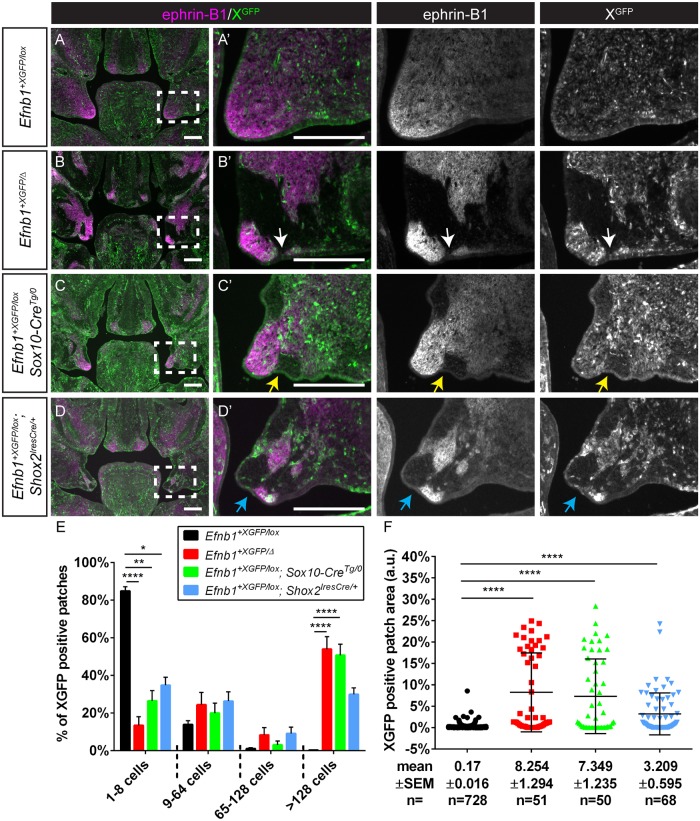
Craniofacial mesenchyme cell segregation correlates with local dysmorphology in the secondary palate.(A, A’) Immunostaining E13.5 frontal sections for EPHRIN-B1 (magenta) and GFP (green) reveals that EPHRIN-B1 protein is strongly expressed in the anterior-middle palatal shelves. Evenly distributed and intermixed XGFP expressing cells are apparent in control Efnb1+XGFP/lox embryos. (B, B’) Cell segregation is visible in the palatal shelves of Efnb1+XGFP/Δ embryos as large patches of EPHRIN-B1 and GFP expression in these structures. The palatal shelves are also smaller and dysmorphic, with changes in shape occurring at boundaries between EPHRIN-B1 expressing and non-expressing domains (white arrow). (C, C’) Generation of EPHRIN-B1 mosaicism specifically in neural crest cells using Sox10-Cre results in dramatic cell segregation in Efnb1+XGFP/lox; Sox10-CreTg/0 palatal shelves, which are smaller and dysmorphic, with regions of dysmorphogenesis correlating with EPHRIN-B1 expression boundaries (yellow arrow). (D, D’) EPHRIN-B1 mosaicism in Shox2IresCre-expressing cells results in cell segregation in Efnb1+XGFP/lox; Shox2IresCre/+ palatal shelves. Areas of dysmorphogenesis are visible at the interface between EPHRIN-B1 expression and non-expression domains (blue arrow). (E) Distribution of percentage of XGFP-positive patches of various sizes. Column height represents means of the distributions across all sections measured for a given genotype, error bars represent S.E.M., *, P<0.05.; **, P<0.01; ****, P<.0001. (F) Patch sizes represented as scatterplots. Horizontal bars represent means, and error bars represent S.E.M. ****, P<.0001. Number of embryos analyzed is presented in S1 Table.